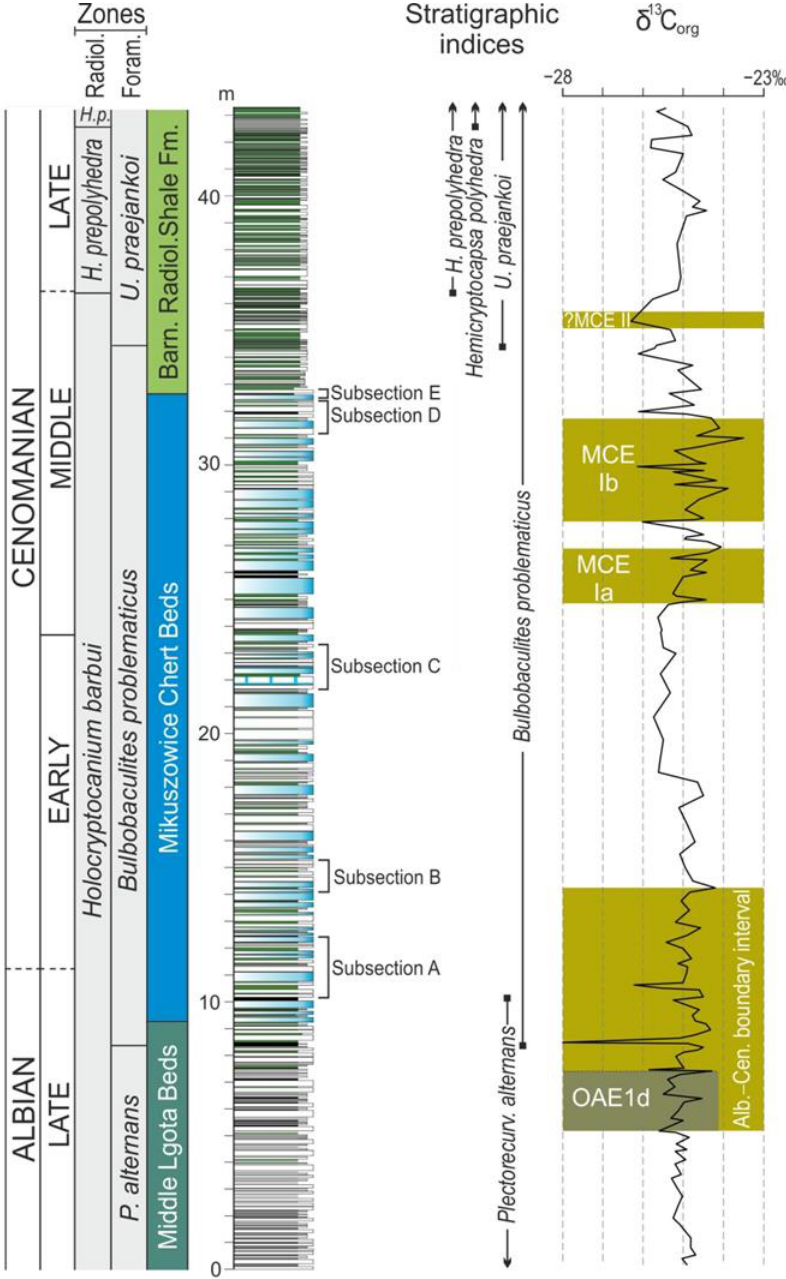
Figure 4. Lithological log of the Barnasiówka-Jasienica section, Silesian Nappe, Outer Carpathians plotted against the main radiolarian and foraminiferal stratigraphic markers, and δ 13 C org curve containing a range of the main carbon isotope events (after [32]). The position of the subsection studied is also presented. U. praejankoi — Uvigerinaminna praejankoi Agglutinated Foraminifera Zone;